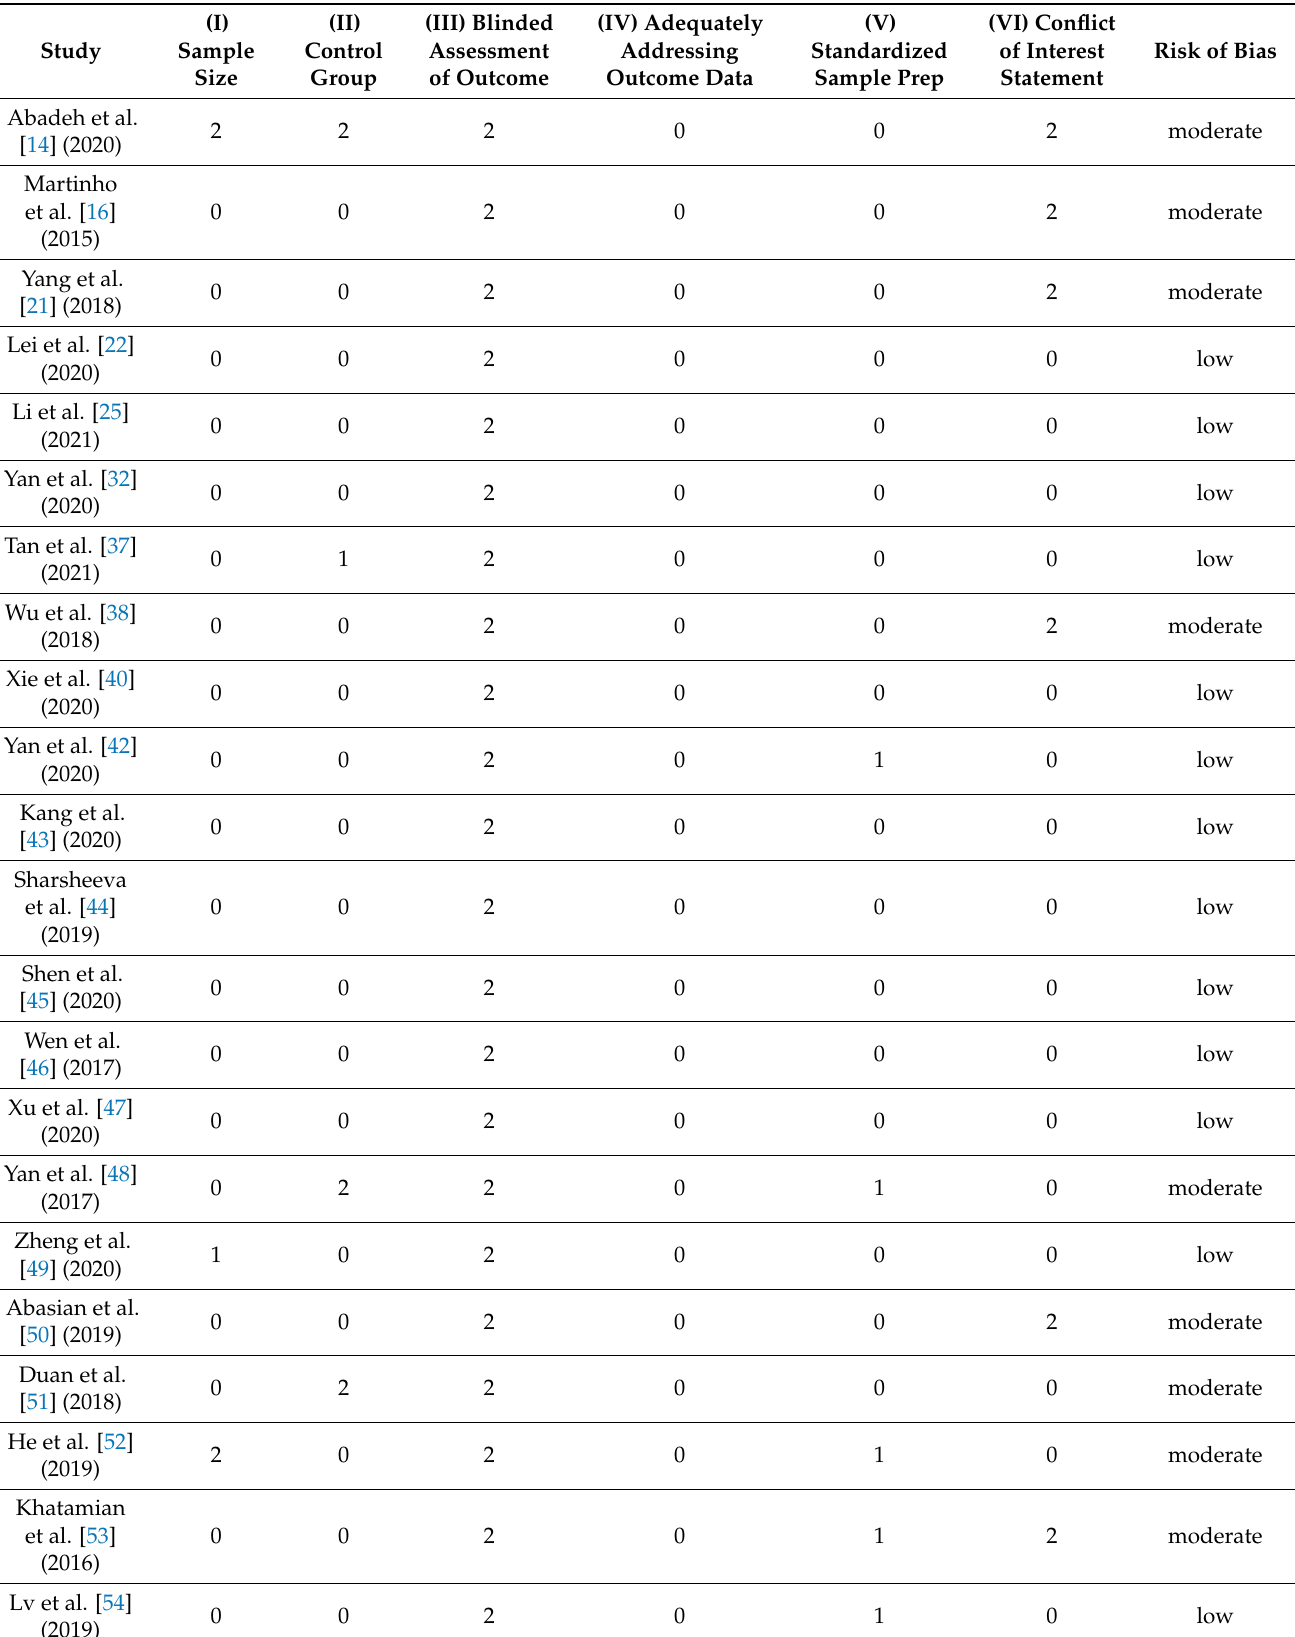
Table 3. Risk of Bias Considering Aspects Reported in Section